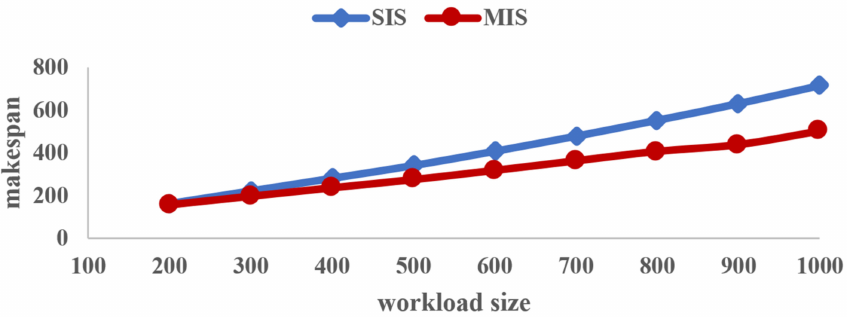
Figure 7. Makespan of the entire workload vs. workload